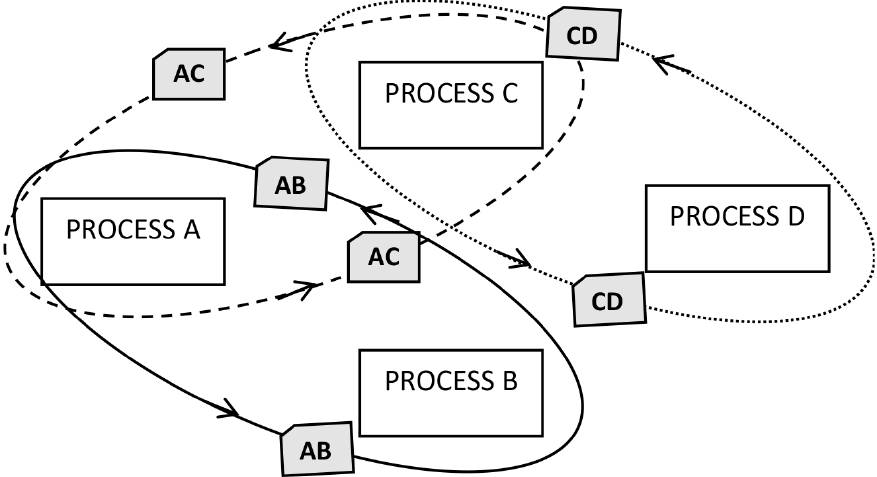
Figure 2. Simple Three Loop POLCA system